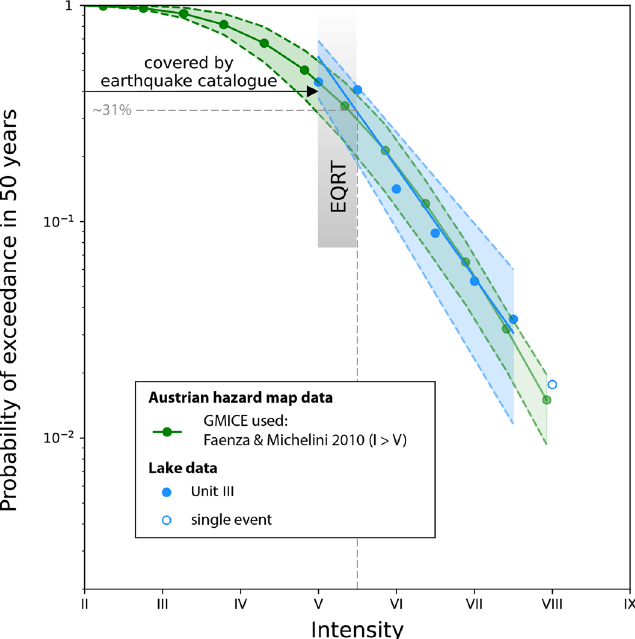
Figure 7. Comparison between the seismic hazard curves derived from lacustrine data of unit III (blue) and the probabilistic seismic hazard analysis based on instrumental seismicity 29 . An exponential fit, i.e. a visually linear decrease when exceedance probability is plotted on a logarithmic scale, is found for the probability of exceedance of certain intensities in 50 years for the lake dataset. The boundaries of the uncertainty range of the lake data (light blue) represent the hazard curves if I = I min for the lower boundary and I = I max for the upper boundary (see Fig. 3). For the PSHA data, the uncertainty range (light green) is bounded by the 16% and 84% quartiles of the probabilities derived from all logic tree branches. Additional—but hardly quantifiable— uncertainty arises from usage of a GMICE for the conversion of PGA to macroseismic